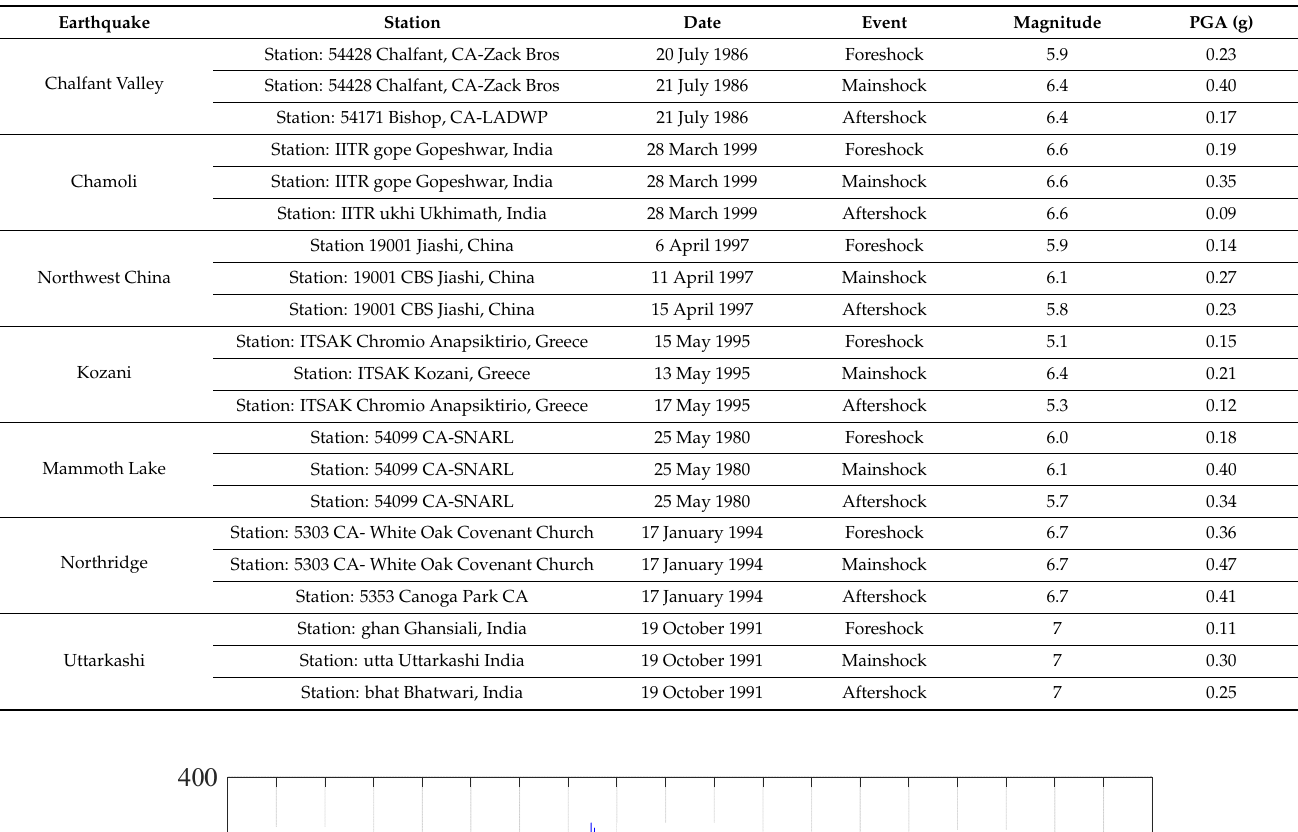
Table 2. Earthquake sequence used for time history analysis (retrieved from https://www. strongmotioncenter.org/, accessed on 15 March 2022).